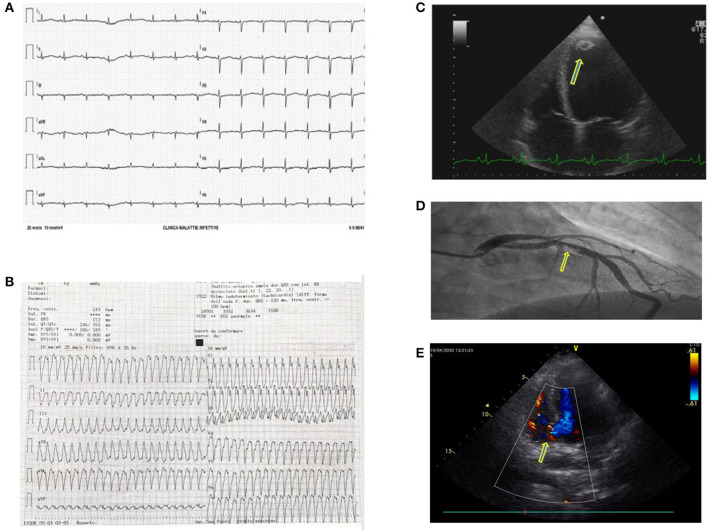
(A) Electrocardiogram (ECG) showing a prolonged QTc interval in a Covid-19 patient treated with hydroxychloroquine and azithromycin. These two drugs combined may prolong the QT interval by more than 500 ms and induce arrhythmias. (B) Sustained ventricular tachycardia in a Covid-19 patient. The ECG showed frequent malignant ventricular arrhythmias. (C) A further Covid-19 related complication was myocarditis probably due to a direct heart muscle infection. This 4D echocardiographic image shows a ventricular dilatation and a concomitant apical thrombus (yellow arrow). (D) Coronary thrombosis in a Covid-19 patient with an acute coronary syndrome. In Covid-19 patients, we frequently found coronary vessel thrombosis obstructing the coronary artery. In this patient, the ECG clearly shows a blood clot obstructing the interventricular coronary artery (yellow arrow). (E) Interventricular septum rupture (yellow arrow, basal septum rupture with shunt) in a Covid-19 patient who arrived late in the coronary unit during S-T elevation myocardial infarction.